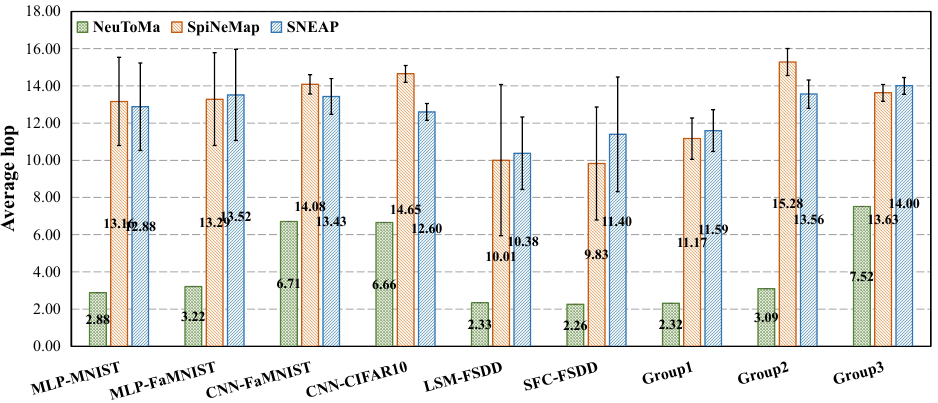
Figure 8. The average hop of spike messages.